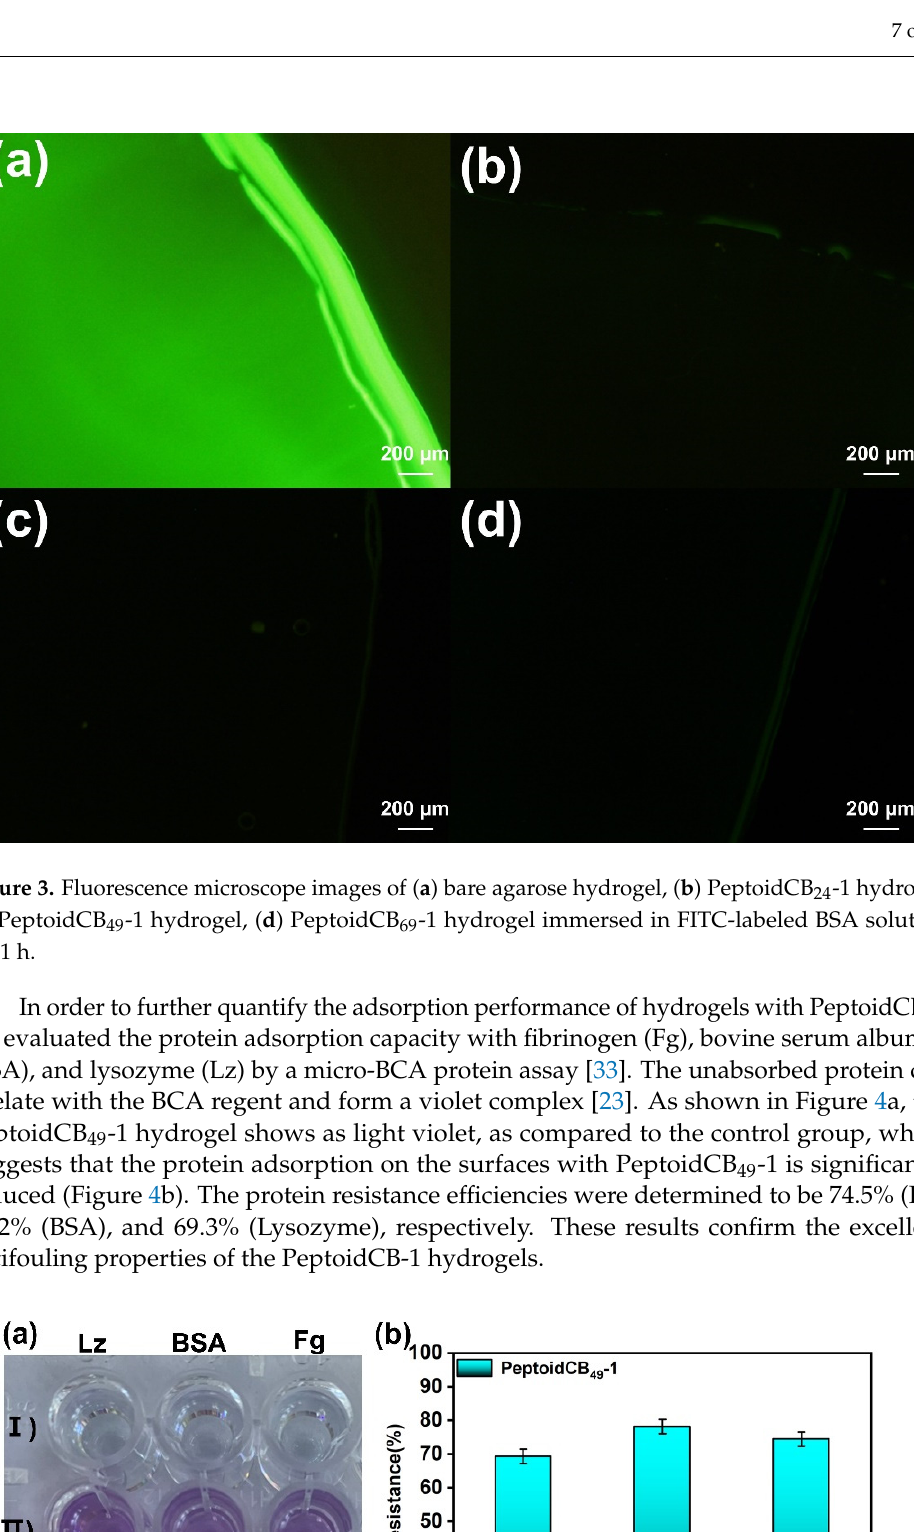
7 of 12 Figure 2. 1 H NMR spectra of CB-modified block copolypeptoids (a) PNAG- b -PNOG, (b) Peptoid QA-2, and (c) Peptoid CB-2. * represents the solvent. Resistance to Protein Adsorption In order to evaluate the adsorption of nonspecific proteins and bacterial adhesion properties of the zwitterionic polymers, we first prepared agarose hydrogels by mixing agarose with CB-modified homopolymer polypeptoid (PeptoidCB m -1) at different DPs. The activity of the hydrogel against protein fouling was assessed by using FITC-labeled bovine serum albumin (BSA) as a model protein, imaged by fluorescence microscopy. Figure 3 shows that fluorescence signals are barely observed in the hydrogels containing PeptoidCB 24 -1 (Figure 3b-d). Increasing the DP of the PeptoidCB m -1 yields similar results. In contrast, the control group of agarose hydrogel without PeptoidCB-1 shows an obvious fluorescence signal (Figure 3a). This indicates that a large amount of proteins are